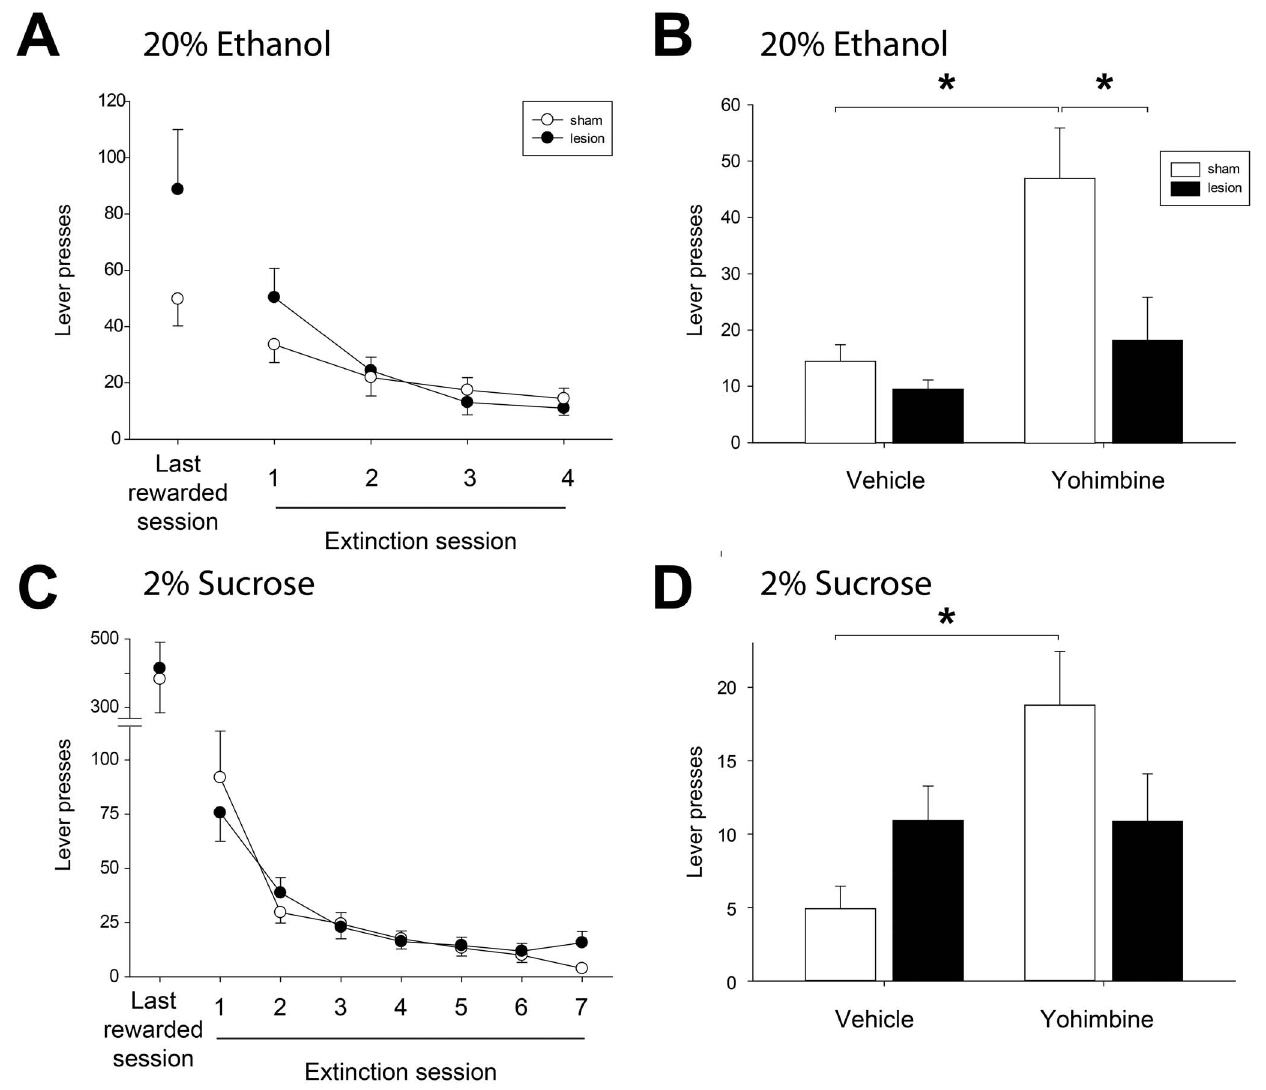
Figure 5. Extinction and reinstatement of ethanol and sucrose seeking . (A) The number of lever presses in lesioned and sham rats did not differ during extinction of operant responding for 20% ethanol. (B) Yohimbine administration reinstated ethanol seeking in sham but not lesioned rats. The number of lever presses by sham rats after yohimbine injection was significantly higher than that occurring after vehicle injection, and higher than lever presses performed by lesioned rats after yohimbine administration. Brackets indicate significant posthoc differences. (C) Sham and lesioned rats showed similar rates of extinction of responding for 2% sucrose. (D) Yohimbine administration induced reinstatement of sucrose seeking in sham but not lesioned rats.